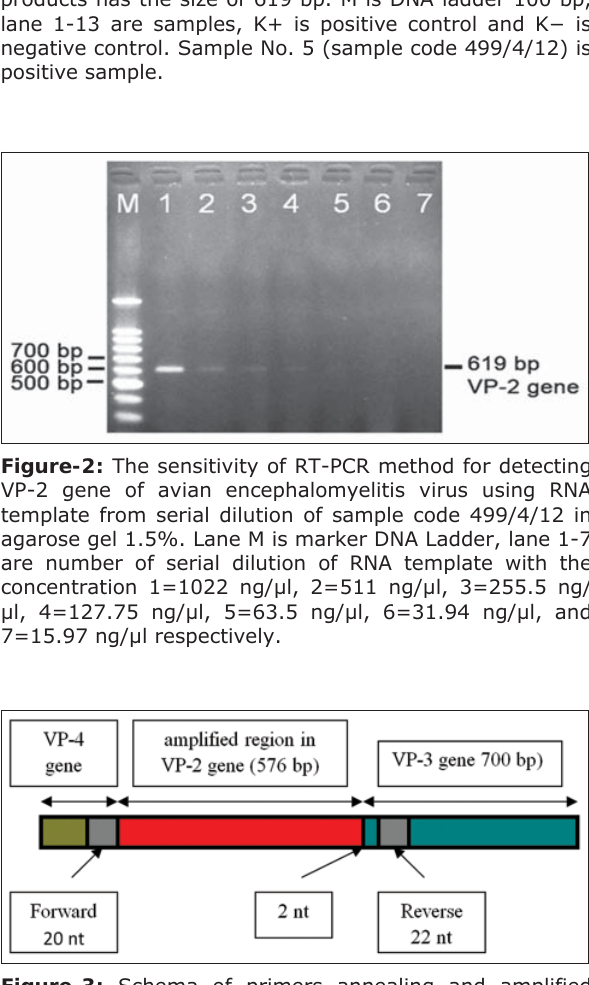
Figure-3: Schema of primers annealing and amplified region in VP-2 encoding gene of